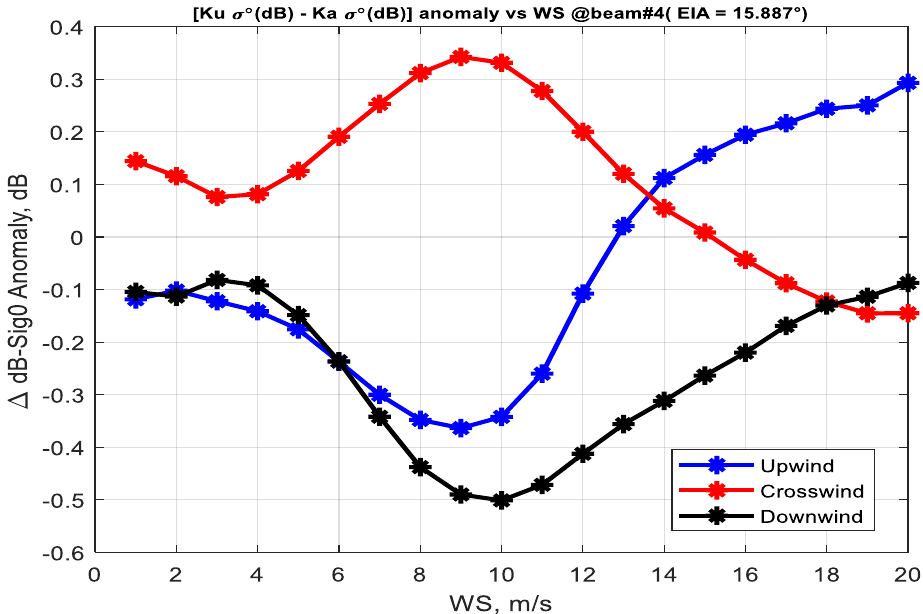
Figure 16. Delta residual (in dB) between KuPR and KaPR σ 0 directional anisotropy as a function of wind speed for upwind, downwind, and crosswind direction at EIA ~= 16 deg.